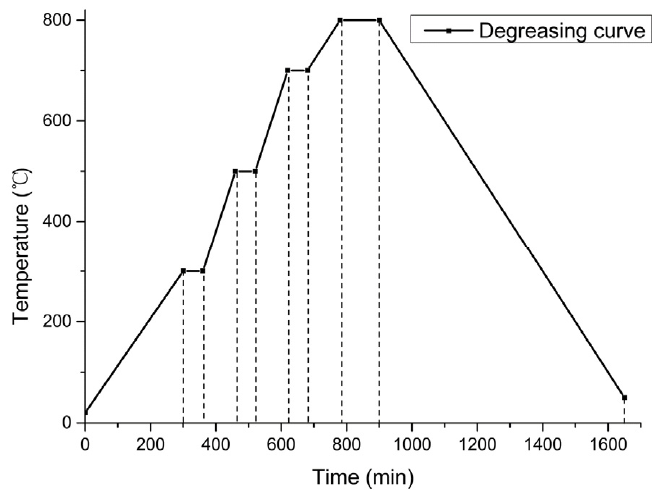
Figure 3. Degreasing curve of sample in vacuum furnace.